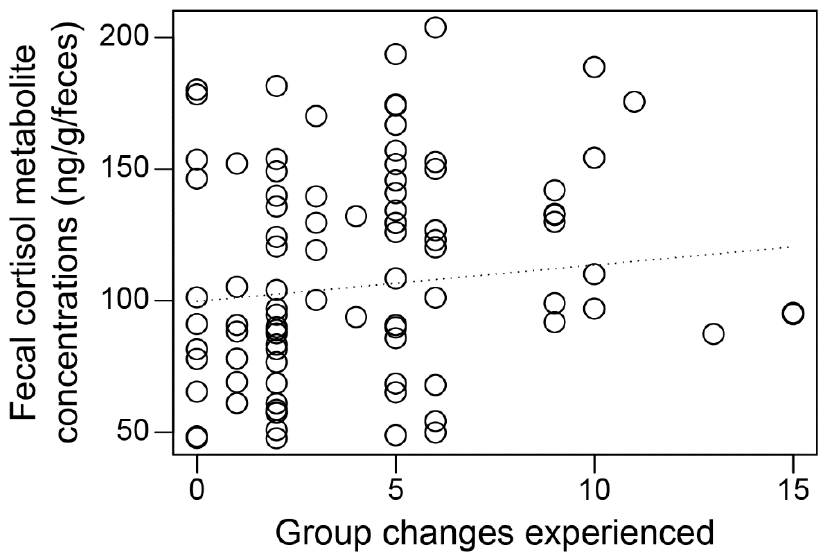
0.82 Model output using raw female group change data: group changes males experi- enced (Figure A1, Linear Mixed Effects Model: estimate = 1.38, SE = 1.83, t = 0.76, p = 0.45); group change timing (Linear Mixed Effects Model: (during) estimate = −1 2.00, SE = 11.45, t = −1 .05, p = 0.30; (after) estimate = 11.10, SE = 18.08, t = 0.61, p = 0.54); visibility (Linear